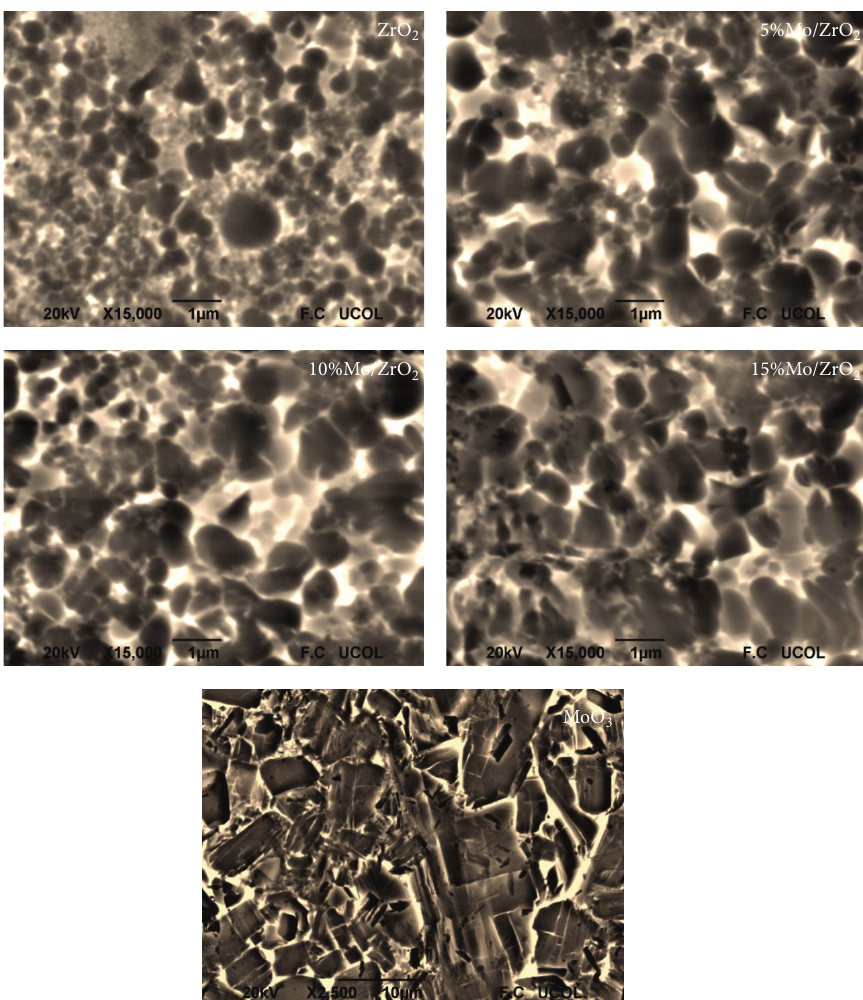
Figure 14: Scanning electron microscopy of ZrO 2 , MoO 𝑥𝑦− /ZrO 2 , and MoO 3